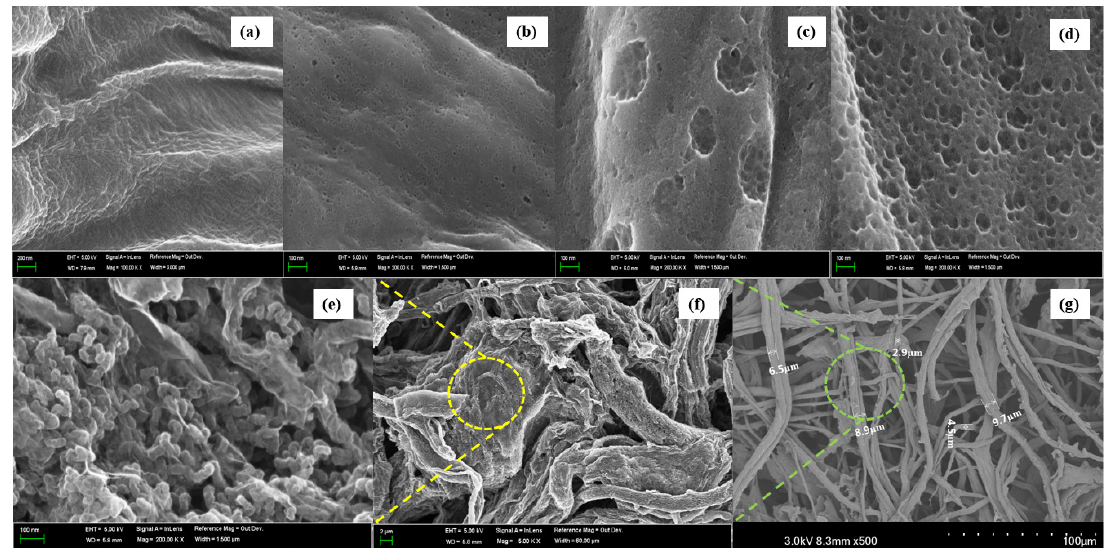
Figure 1. Morphological characterization of the activated carbon papers (ACPs) and SEM images of ( a ) carbon paper, ( b ) ACP-500, ( c ) ACP-700, ( d ) ACP-900, ( e ) (magnification: 20,000 × ), ( f ) (magnification: 5000 × ), and ( g ) (magnification: 500 × ) ACP-1100.